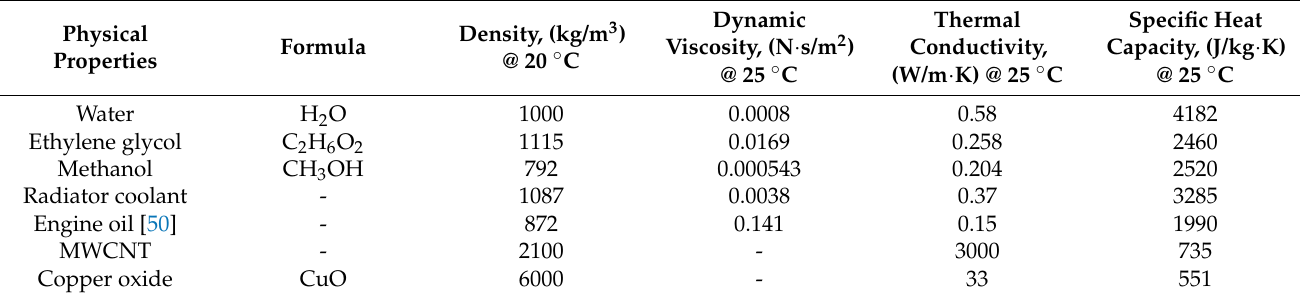
Table 2. Properties of different nanoparticles and base fluid